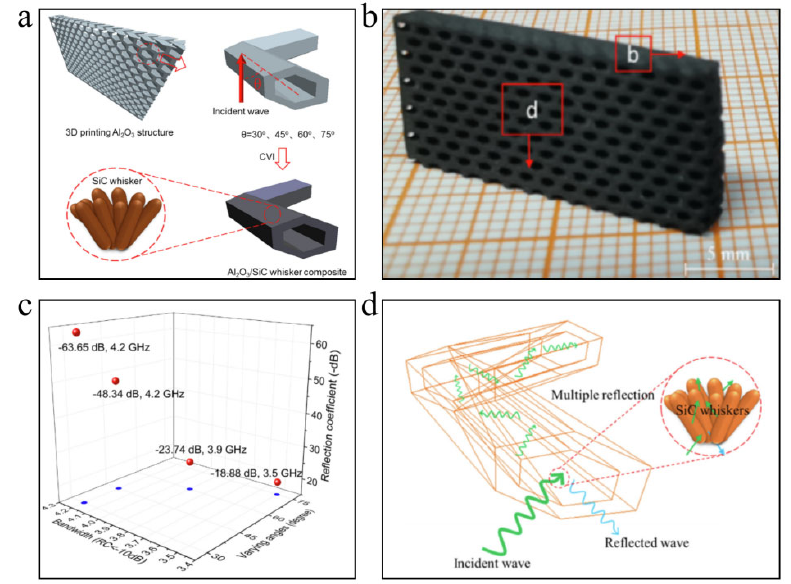
Fig. 46 (a) Structural designed model; (b) Al 2 O 3 –SiC w ceramic cellular structures; (c) excellent electromagnetic wave (EMW) absorption behavior; (d) electromagnetic wave (EMW) absorption mechanism. Reproduced with permission from Ref. [123],